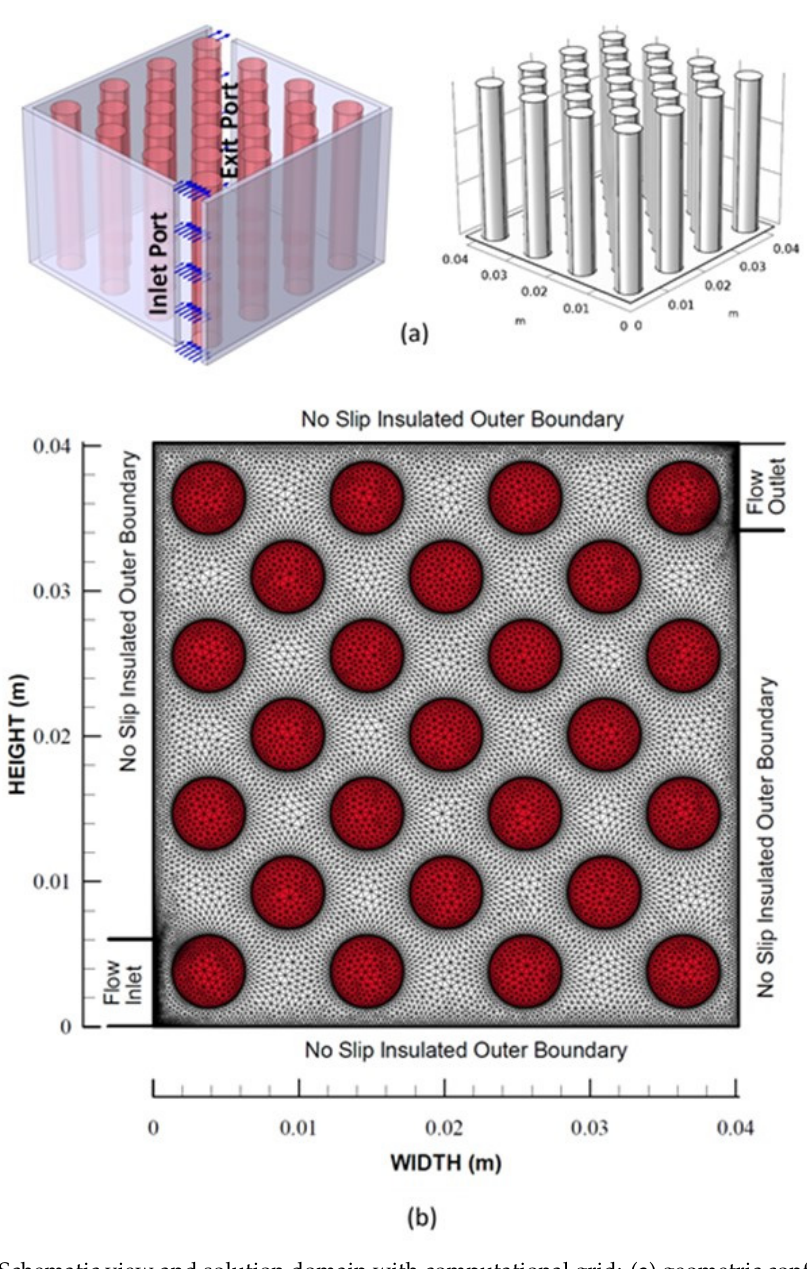
Figure 1. Schematic view and solution domain with computational grid: ( a ) geometric configuration of fin, and ( b ) solution domain with boundary conditions. Simulations are carried out for fin surface confiured as (i) no slip (hydrophilic) or (ii) slip (hydrophobic).